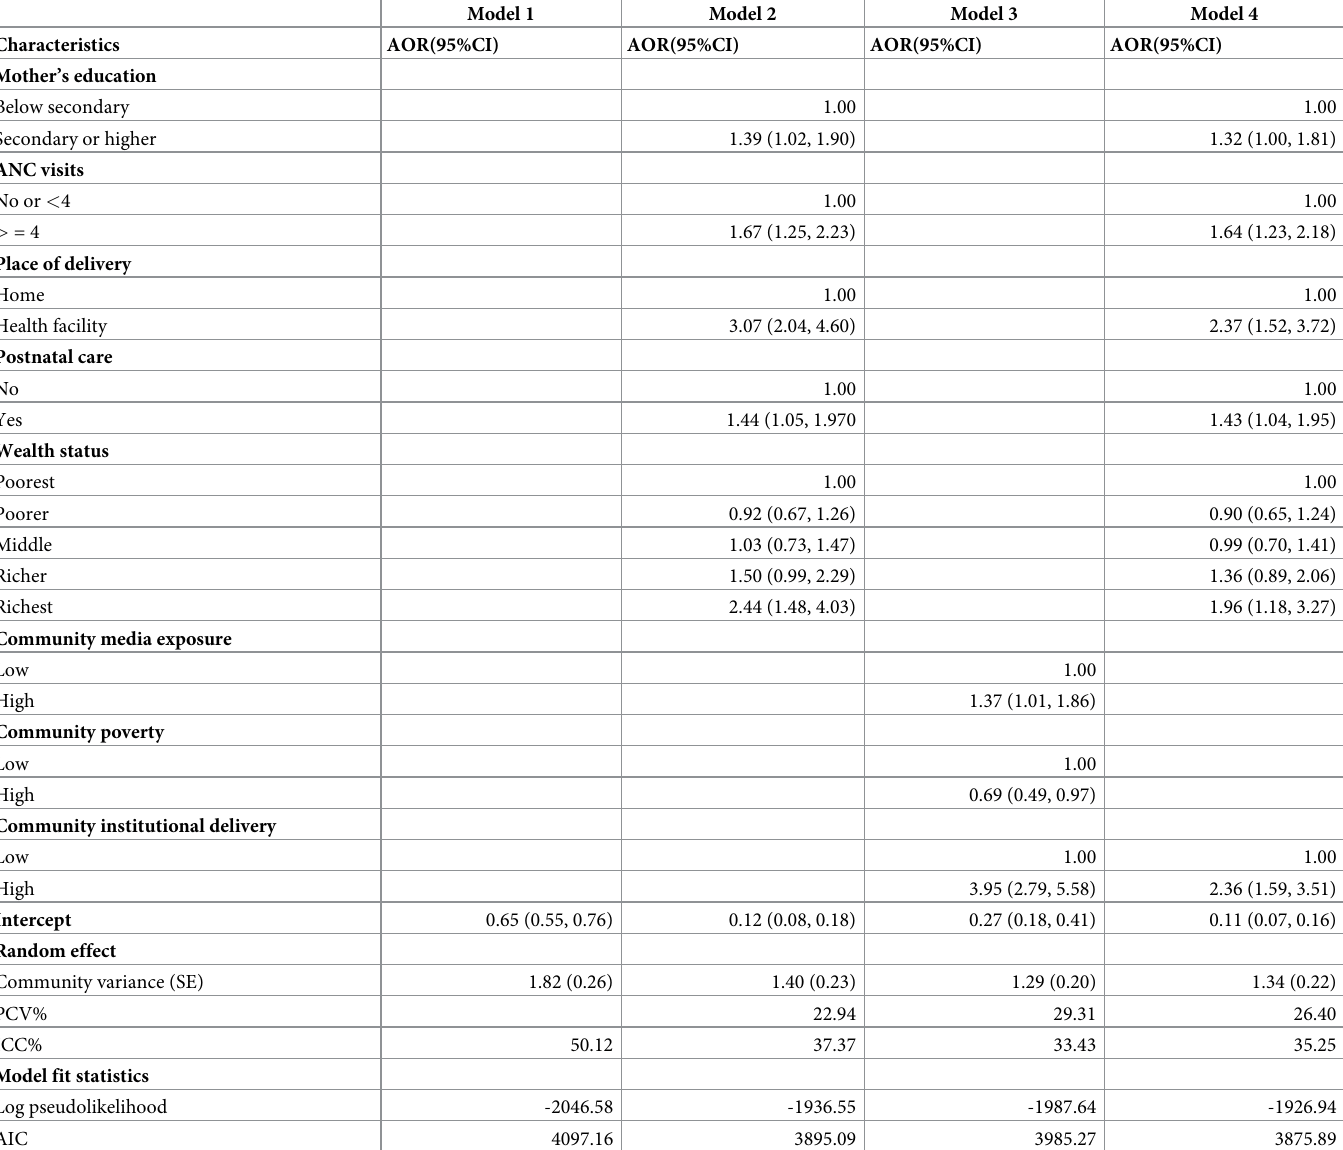
Table 4. Multivariate multilevel logistic regression analysis of individual and community level factors with childhood full immunization among 12–23-month-old children in the DRC in 2013–14 ( n =